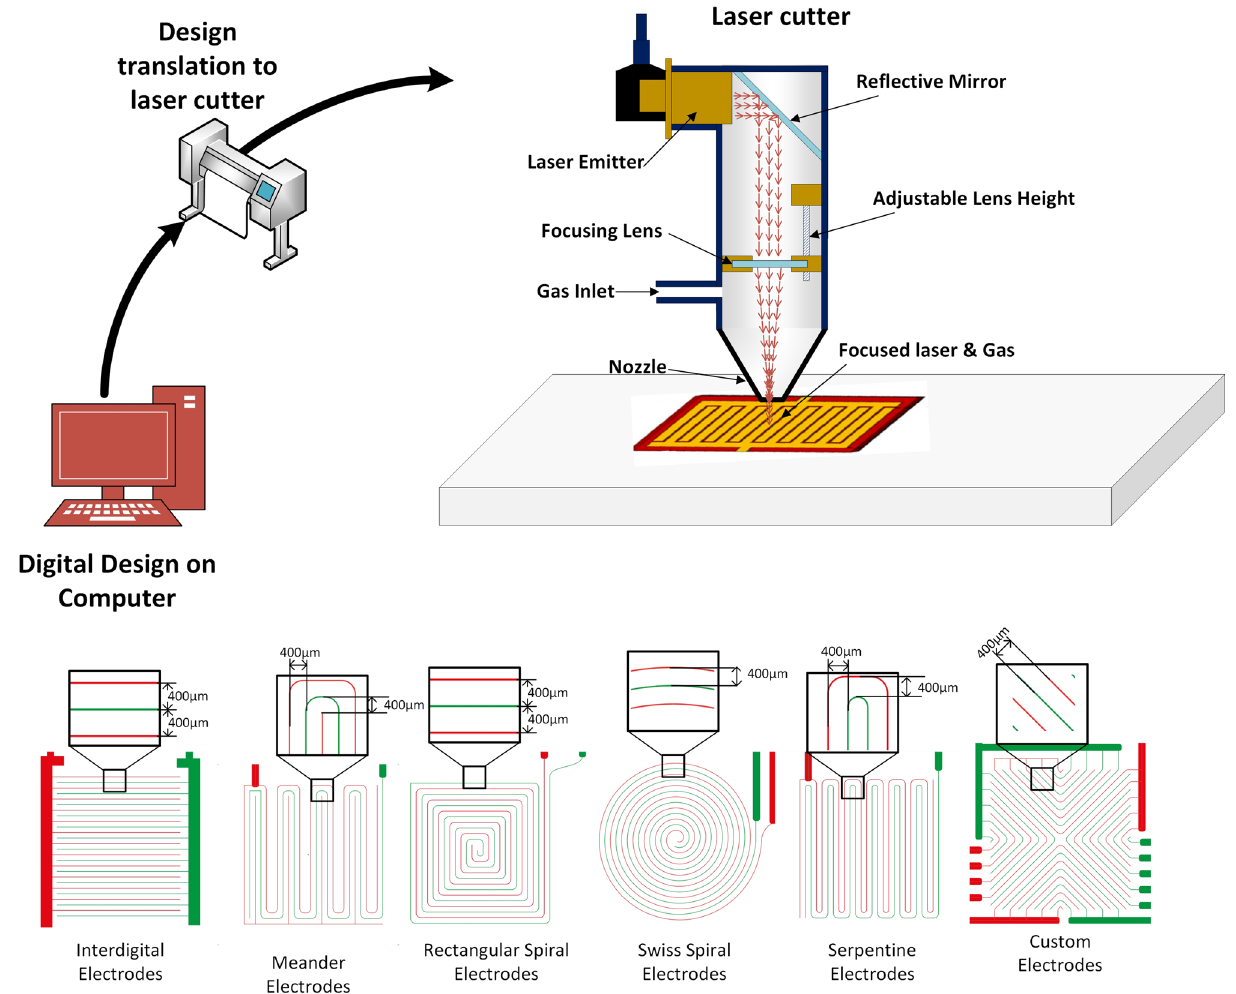
Figure 9. Transduction electrode fabrication process and transduction geometries.